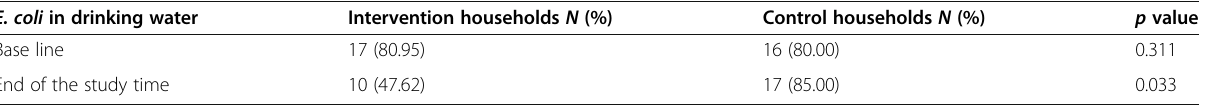
Table 5 Intervention and control households ’ numbers with E. coli in drinking water at baseline and end line, in rural kebeles of Dire Dawa, east Ethiopia,